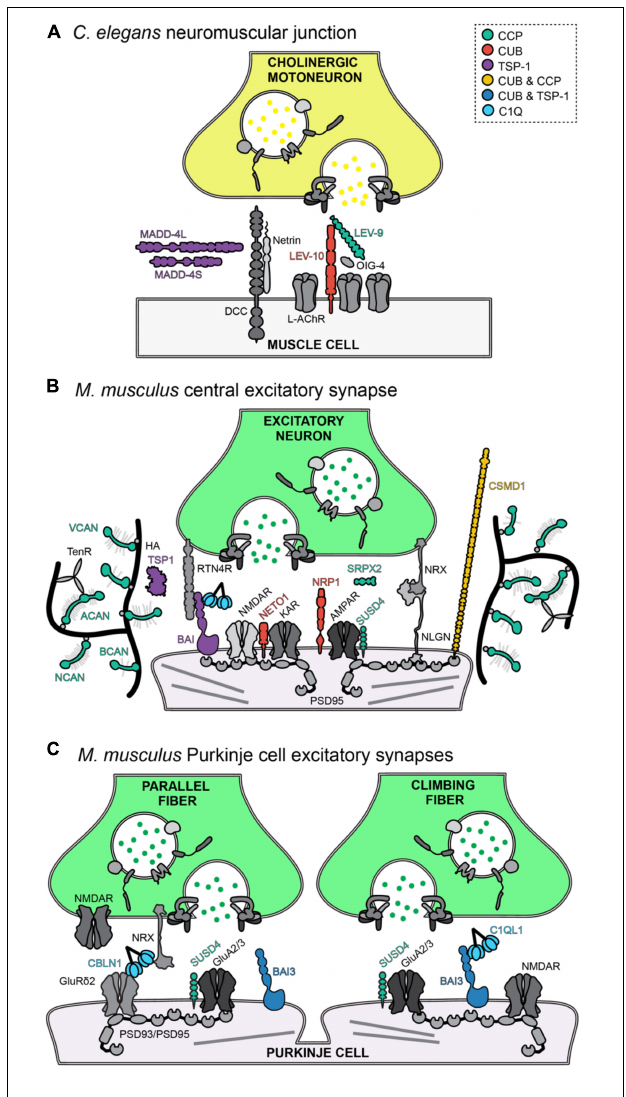
FIGURE 3 | CCP-, CUB-, and TSP-1-domain containing proteins in C. elegans and in mammalian synapses. (A) In C. elegans , the three classes of proteins are found in cholinergic neuromuscular junctions and play different functions in synapse specification (MADD-4) and receptor clustering (LEV-9 and LEV-10). (B) In M. musculus , the three domains are found either alone (SUSD4, NETO1, ... ) or in combination (CSMD1, BAI3) in proteins of excitatory synapses. (C) The C1Q domain, absent in C. elegans , is found in proteins that specify two different types of excitatory synapses made on a single target, the Purkinje